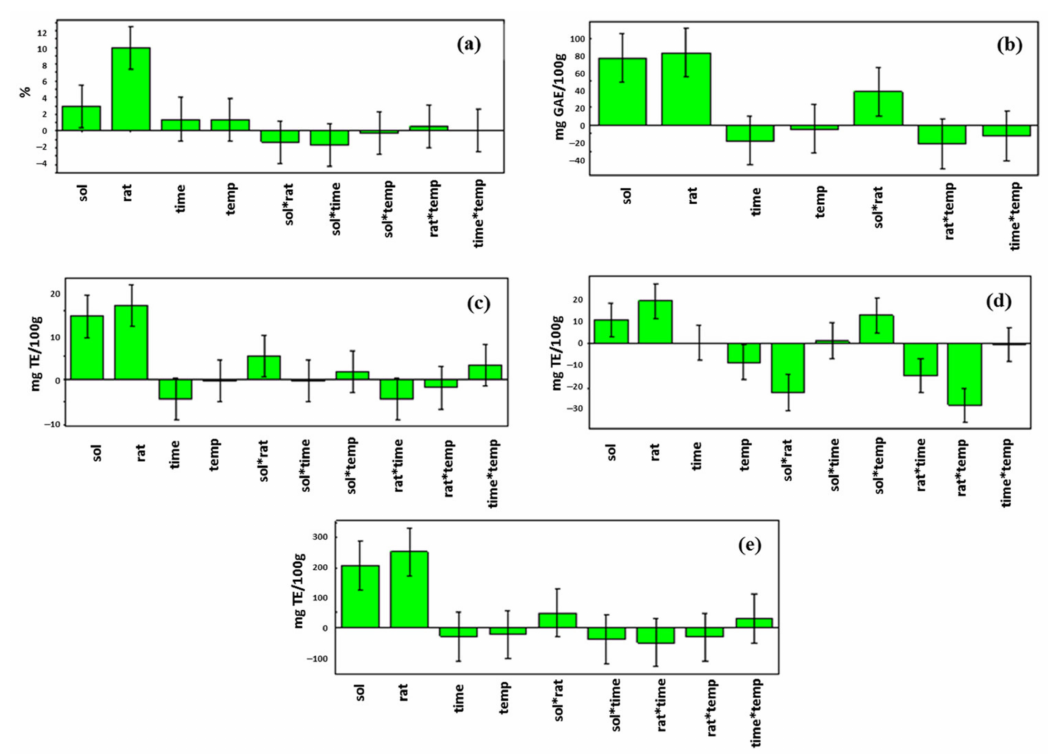
Figure 1. Coefficient plots showing the effect of the factors: water % in ethanol (sol), liquid/solid ratio (rat), time, and temperature (temp) and their interactions on the responses: ( a ) yield, ( b ) TPC ( c ) FRAP ( d ) DPPH ( e ) ABTS. The error bars indicate the confidence intervals.